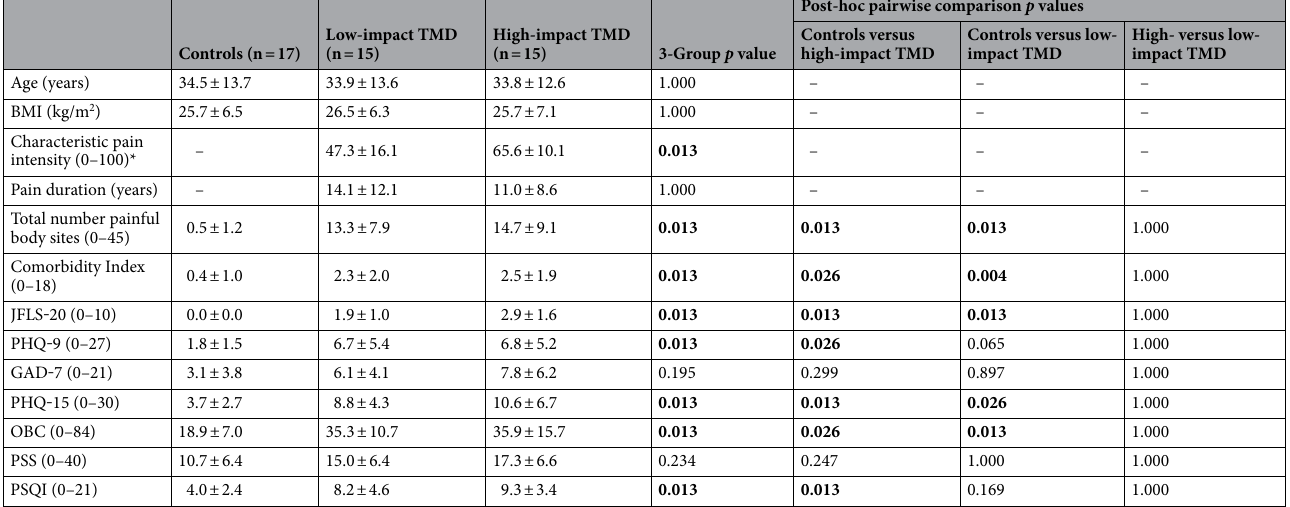
Table 1. Clinical and demographic characteristics collected at visit 1. Results are reported as means and standard deviations. Two group comparisons were conducted using Mann–Whitney U test, while three group comparisons were conducted using Kruskal–Wallis test. p values presented for the main between-group comparisons are Bonferroni corrected for multiple comparisons. BMI body mass index, JFLS jaw